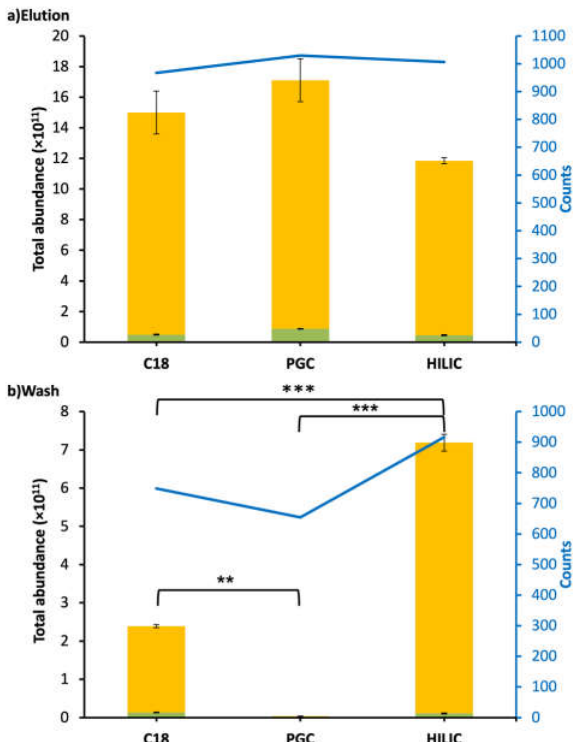
Figure 3. Bar graphs and line charts (blue) of total abundance and counts of CMP-derived peptides found in the intestinal digestive sample followed by C18, PGC, and HILIC SPE. Abundances were based on the total peak abundances of all of the CMP-derived peptides. ( a ) Elution fraction. ( b ) Wash fraction. Peptides with O-glycan(s): green; peptides without O-glycan(s): yellow. Asterisks indicate statistically significant differences; ** means p ≤ 0.01, *** means p ≤ 0.001.